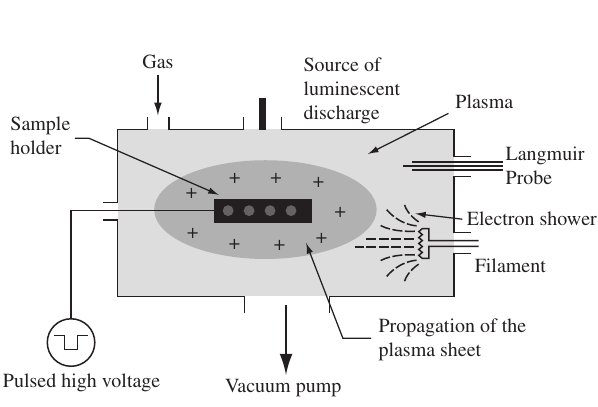
Figure 1. Schematic diagram for plasma immersion ion implantation ap- paratus.